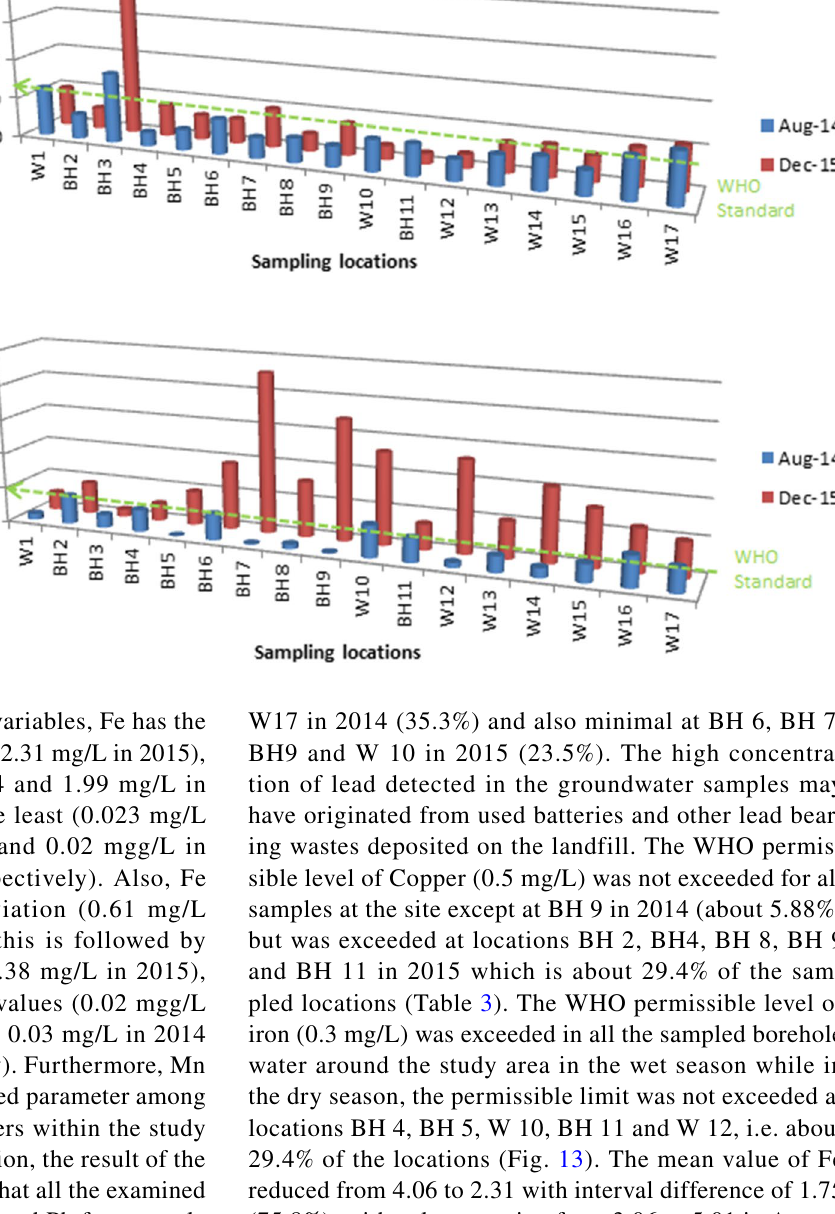
Fig. 11 Seasonal variations in Cl concentration of water sample versus WHO standard around the Olusosun dumpsite